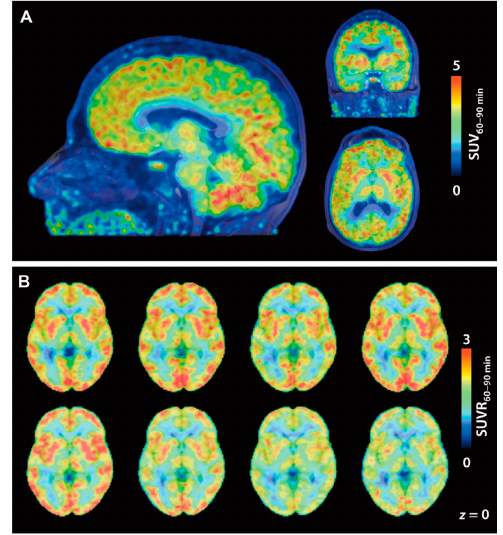
Figure 4. [ 11 C] 8 PET images in a first-in-human study. ( A ) Brain SUV images averaged from 60 to 90 min p.i. of [ 11 C] 8 (174 MBq). PET images are overlaid on MRI; ( B ) [ 11 C] 8 SUVR images of eight individual subjects. SUV 60–90 min was normalized to white matter as a reference. (Reproduced with permission from Wey et al. Sci Transl Med; The American Association for the Advancement of Science, 2016